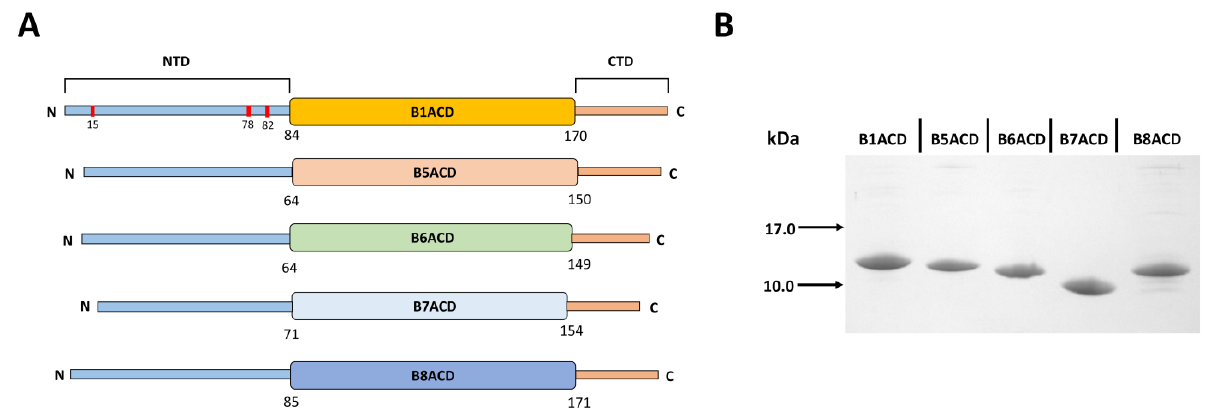
Figure 1. ACDs of selected human sHsps. ( A ) Domain structure of five human sHsps. NTD: N- terminal domain; ACD: α -crystallin domain; CTD: C-terminal domain. Ser residues phosphorylated in HspB1 were marked with red lines and replaced by Asp in 3D mutant. ( B ) Tricine–SDS gel electrophoresis of B1ACD, B5ACD, B6ACD, B7ACD and B8ACD. An amount of ~2 µ g of protein was loaded onto each track.